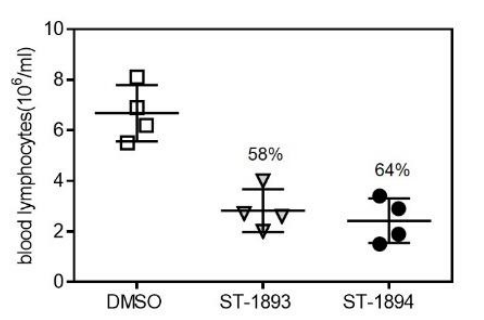
Figure 5. Effect of ST-1893 and ST-1894 on the number of lymphocytes in mice. C57BL/6J wild-type (wt) mice were injected intraperitoneally with 5 mg/kg ST-1893, ST-1894, or DMSO in phosphate- buffered saline (PBS) as a control, and, after 24 h, blood was collected in ethylenediaminetetraacetic acid (EDTA)-K3-coated microvettes with cardiac puncture under deep terminal isoflurane-induced anesthesia. The number of lymphocytes per mL was assessed as explained in Section 4 and is presented as means ± SD ( n = 4).